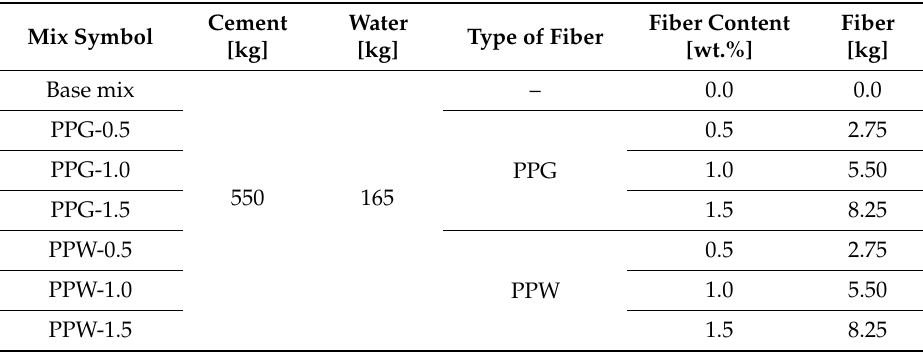
Table 5. Mix proportions (1 m 3 ).